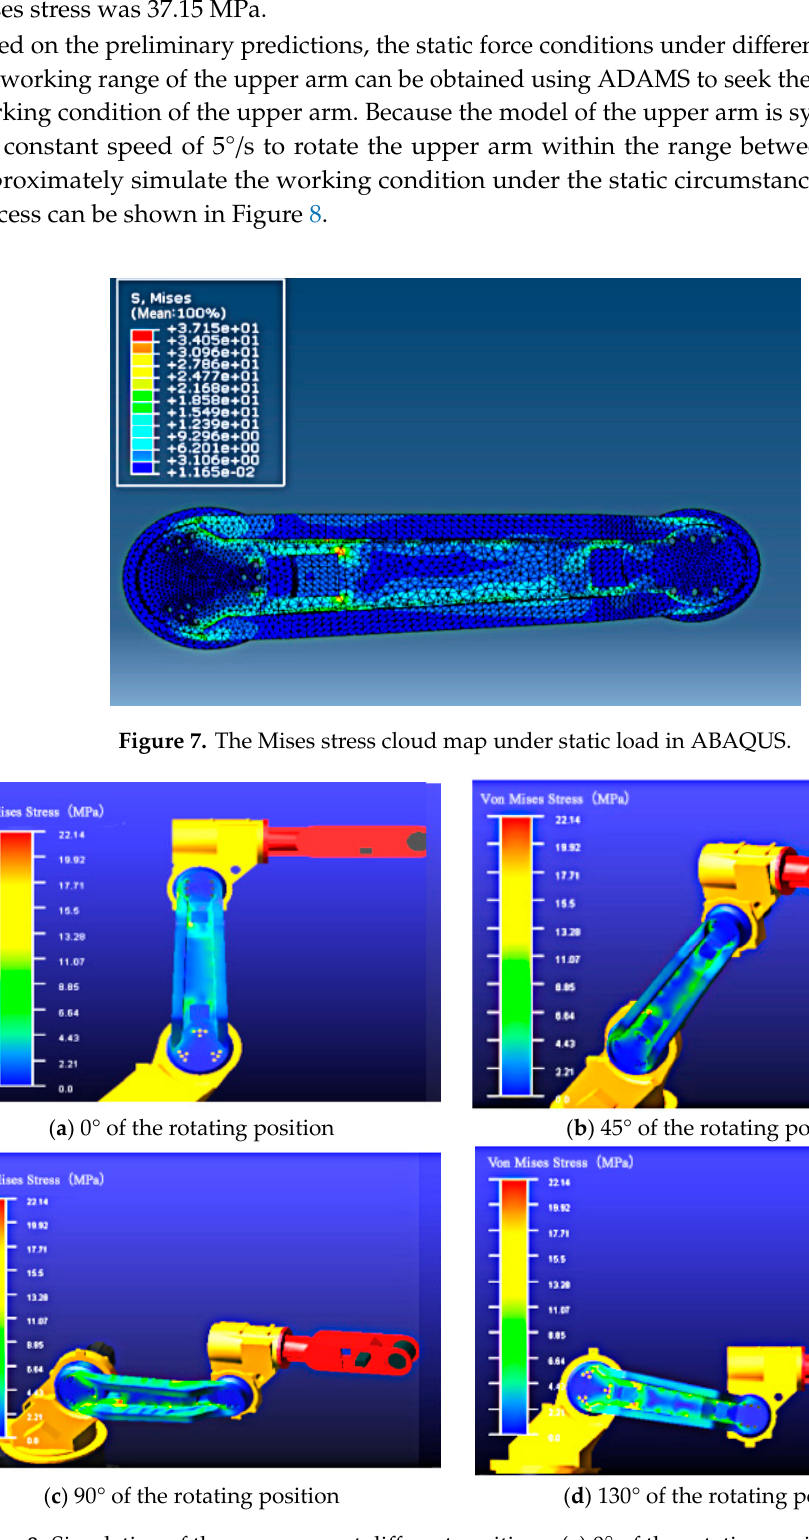
Table 2 showed the maximum stress at different rotating positions.